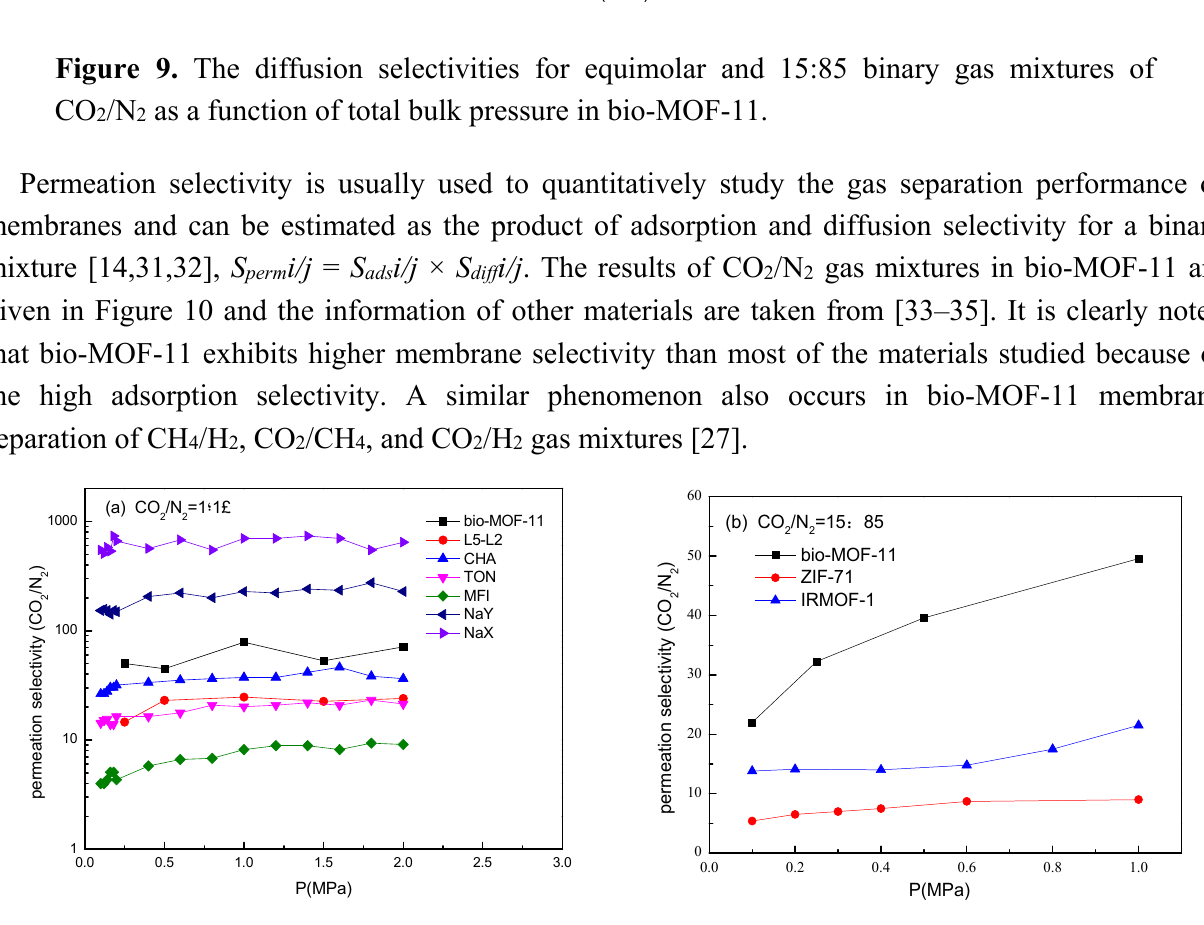
Figure 10. Comparison of permeation selectivities for ( a ) equimolar and ( b ) 15:85 binary gas mixtures of CO 2 /N 2 as a function of total bulk pressure in bio-MOF-11 with other MOFs and zeolites at 298